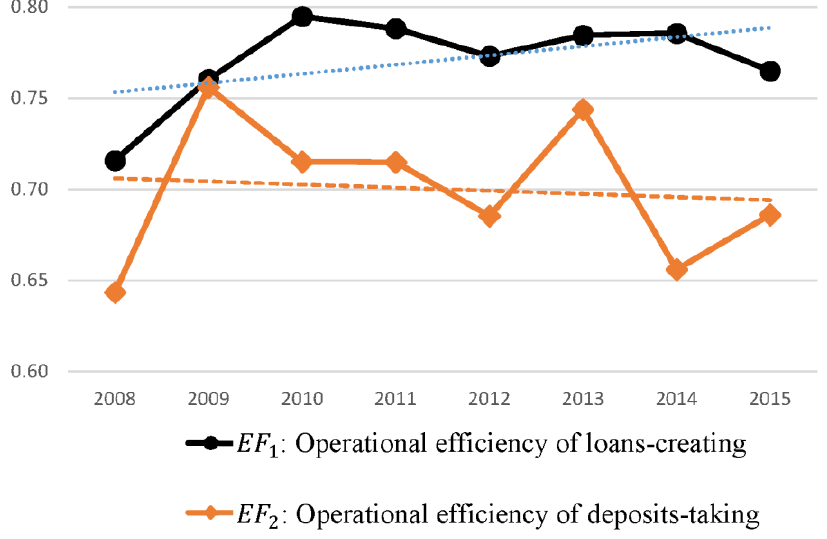
Figure 5. Results of SEM: average operational efficiency over time.